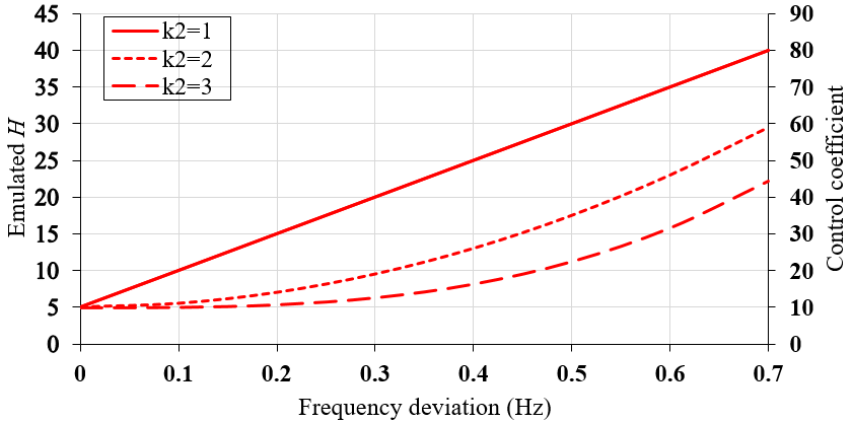
Figure 4. Comparison of inertia constant and control coefficient for the proposed inertial response emulated scheme ( k 2 = 1, k 2 = 2, k 2 = 3).